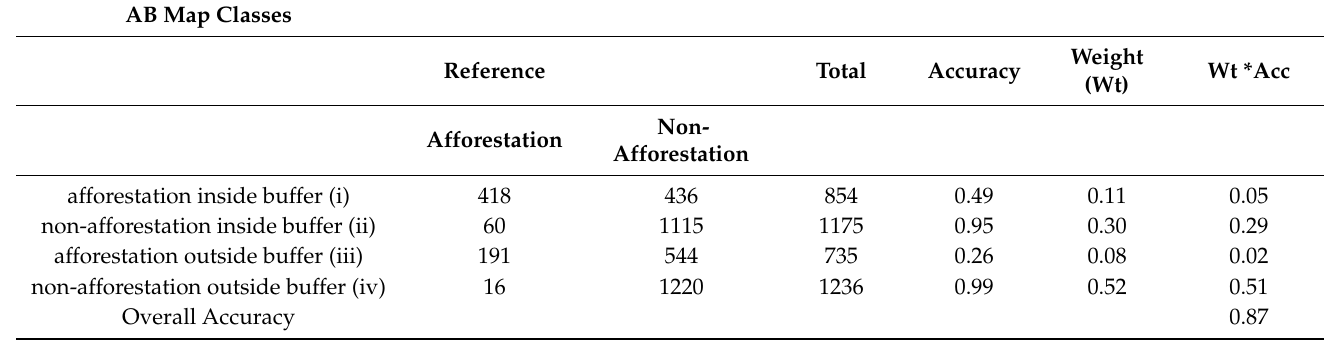
Table A2. Overall accuracy assessment for the map. The table shows the overall and the class accuracies for the map, estimated from the confusion matrix and the sample of 4000 points.